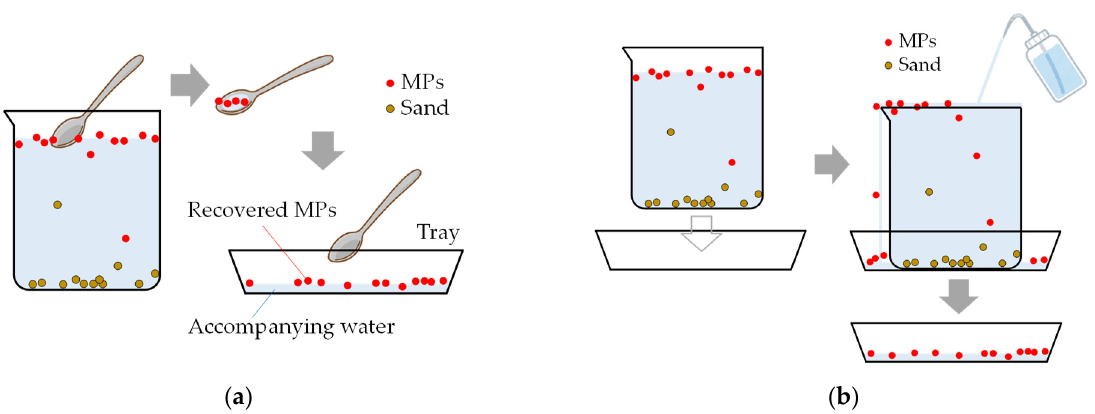
Figure 5. Recovery of MPs: ( a ) spoon method; ( b ) overflow method.